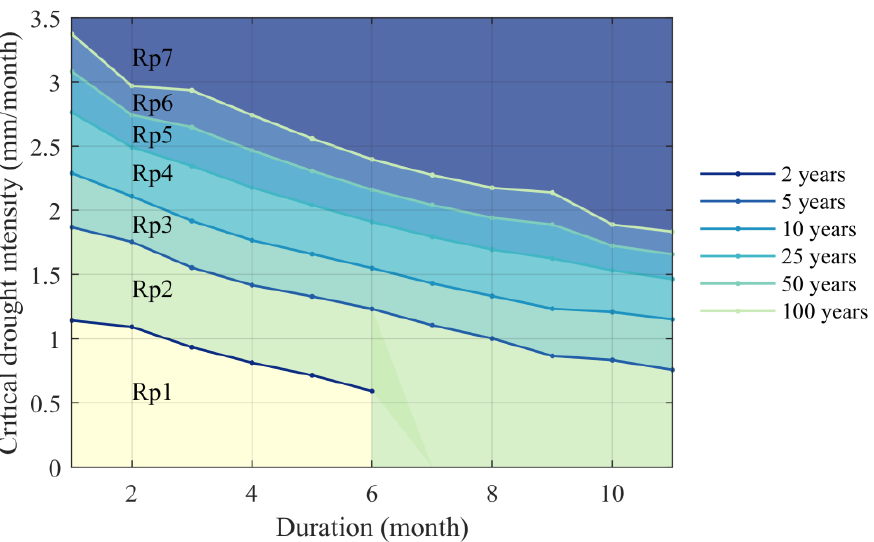
Figure 5. SPI6 critical drought IDF curves representation for CAPESTRANO-Idro station. Each shaded color represents a different Rp class, while each line is a critical drought IDF for a fixed return period (RP).